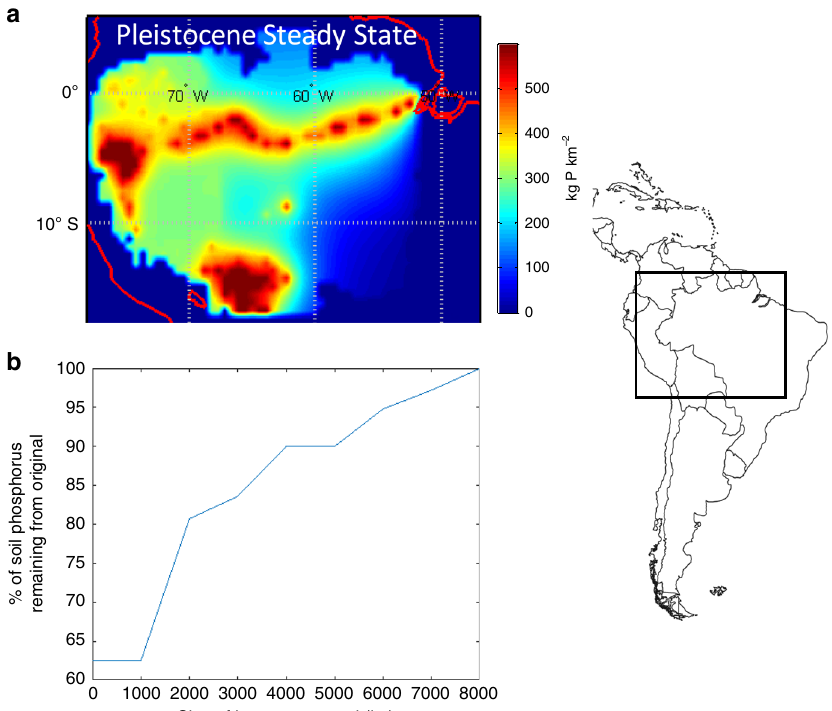
Fig. 4 A decrease in the mean size of South American fauna is predicted to decrease soil fertility (phosphorus) throughout the Amazon basin. Predictions for how the steady state fertility of the Amazon basin (soil phosphorus concentrations) has changed in response to the megafaunal extinctions. This simulation is characterized by lateral diffusivity of nutrients, Φ , by mammals away from the Amazon river fl oodplain source. The diffusivity of nutrients through the Amazon via ingestion, transport, and eventual defecation yields a Φ value of 4.4 km 2 yr − 1 (based on Doughty et al. 27 ). a Simulated steady state soil P concentrations across the Amazon Basin with the now extinct megafauna; b With the extinction of large mammals and a continued forecasted reduction in mammal body size, the percentage of original steady state P concentrations in the Amazon Basin will decrease. Here, under a series of size thresholds for the extinct megafauna, we expect a 20 – 40% reduction in soil steady state P concentrations. For instance, a 5000kg size threshold removes all animals above 5000 kg and continental P concentrations are reduced by ~10%. A size threshold of 0 has all extant South American